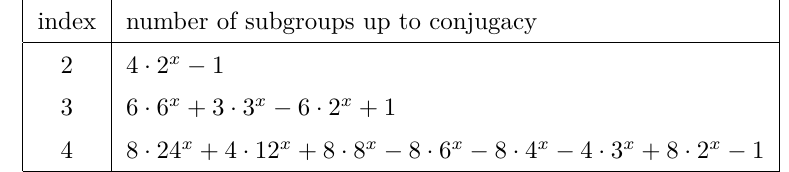
Table 1 . The number of subgroups of the fundamental group of a Riemann surface of a given index. Here, x = 2 g − 2 . The structure P n a a x for n a integers persists also at higher index a | d !